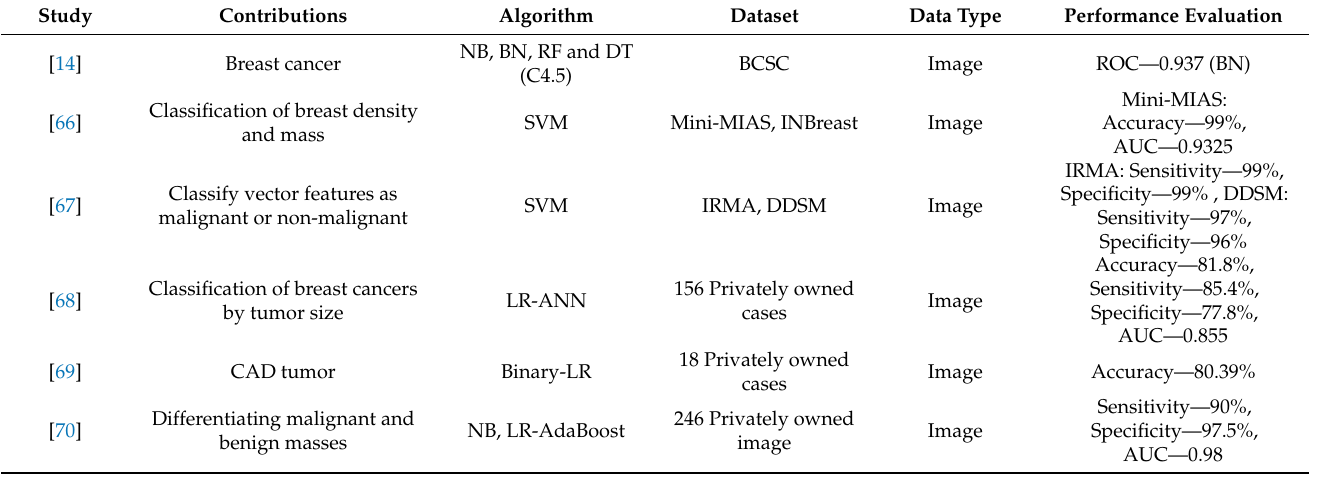
Table 5. Referenced literature that considered machine-learning-based breast cancer disease